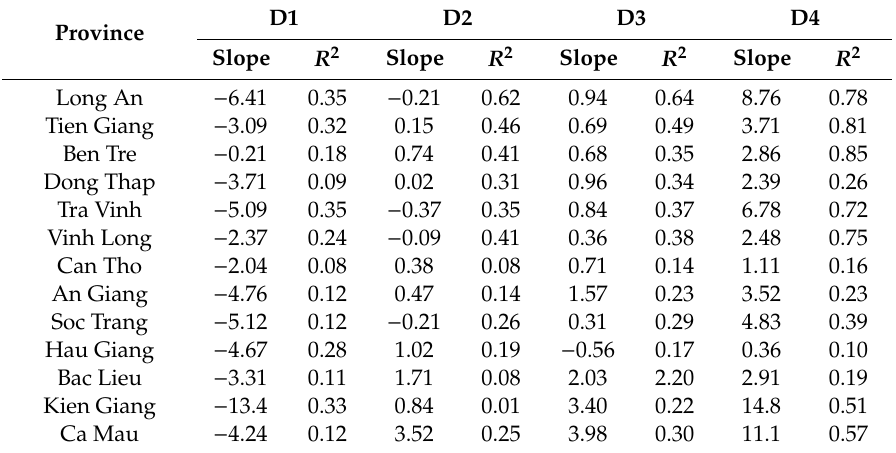
Table 6. Summary of the results corresponding to the trend of area slope and correlation coe ffi cients among di ff erent drought categories by provincial level. All cases: p < 0.01.